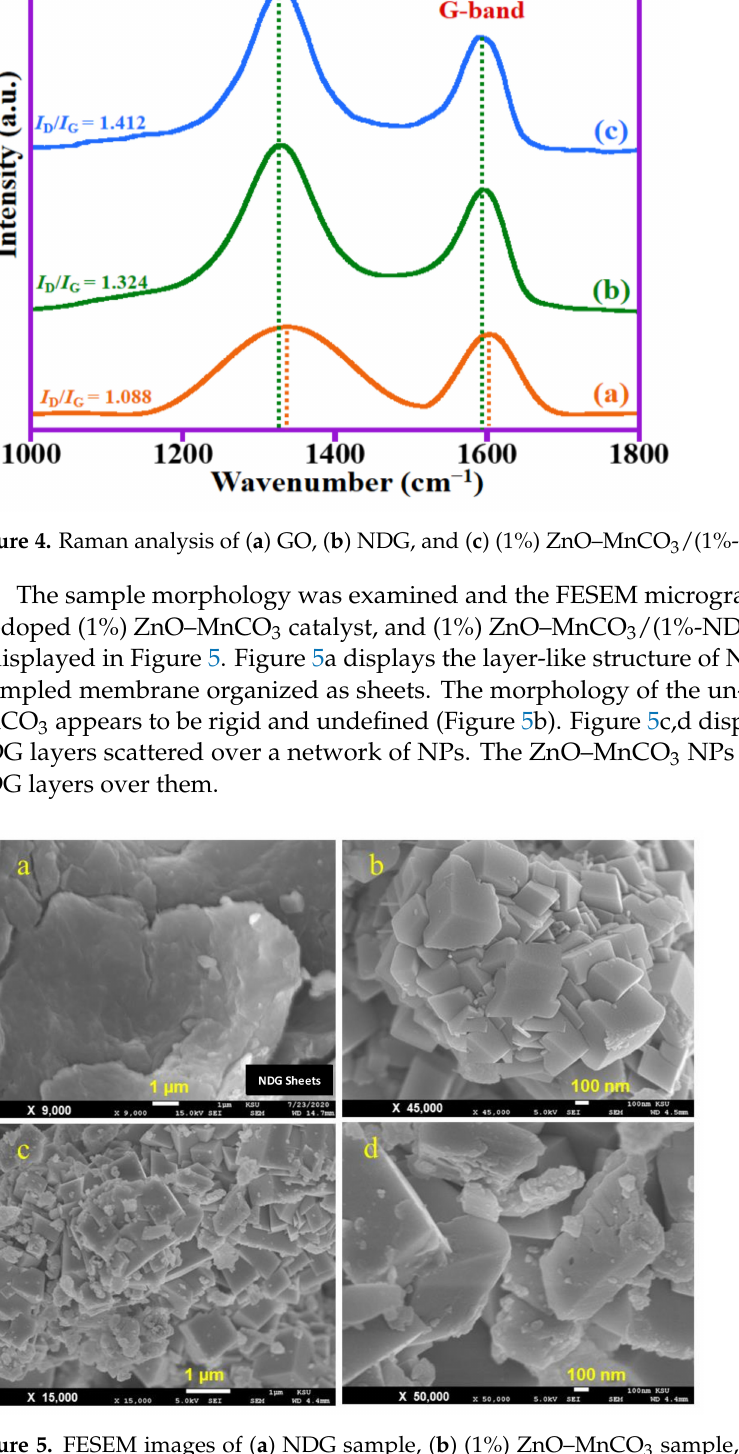
Figure 5. FESEM images of ( a ) NDG sample, ( b ) (1%) ZnO–MnCO 3 sample, and ( c , d ) (1%)ZnO– MnCO 3 /(1%-NDG) sample showing presence of NDG